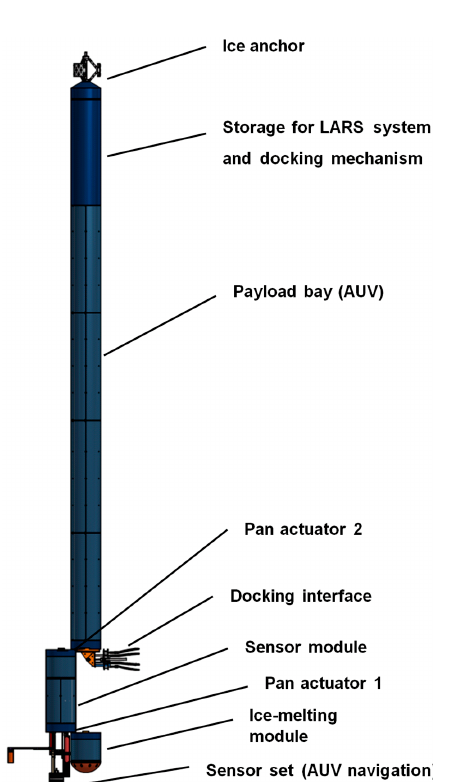
Figure 6. Ice ‐ shuttle ‐ system, which has been designed as a transport system, as well as a docking station for an AUV. The thermal melting head melts a hole into the ice, allowing the whole device to pass through. After penetration into liquid water, the ice ‐ anchor holds the ice ‐ shuttle in place, while the lower section unfolds for vehicle localization and docking. The AUV (contained in the payload bay) is then released into the